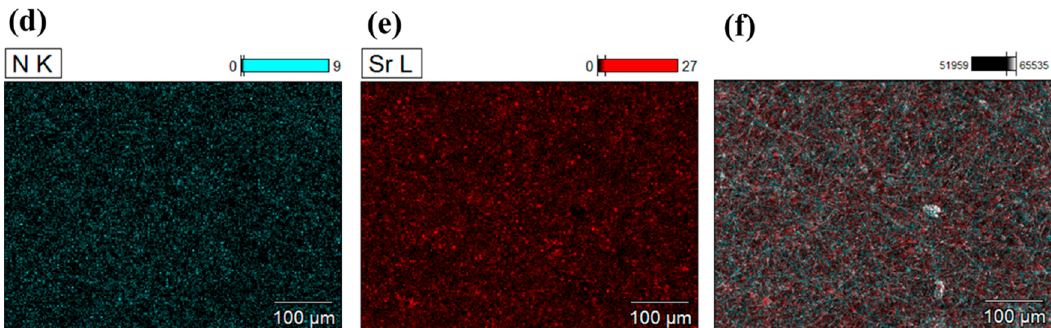
Figure 4. EDS mapping for PVDF/ML and PAN/ML. ( a ) Mapping for fluorine (F) in PVDF fibers; ( b ) mapping for strontium (Sr) in ML particles; ( c ) integrated image of F and Sr of ML/PVDF; ( d ) mapping for nitrogen (N) in PAN fibers; ( e ) mapping for strontium (Sr) in ML particles; ( f ) integrated image of N and Sr of ML/PAN.